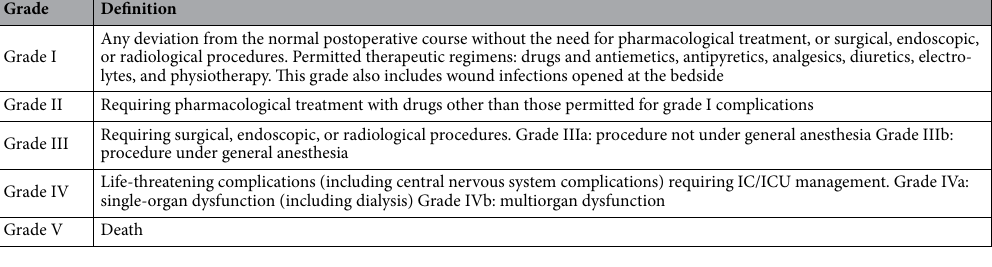
Table 3. Clavien